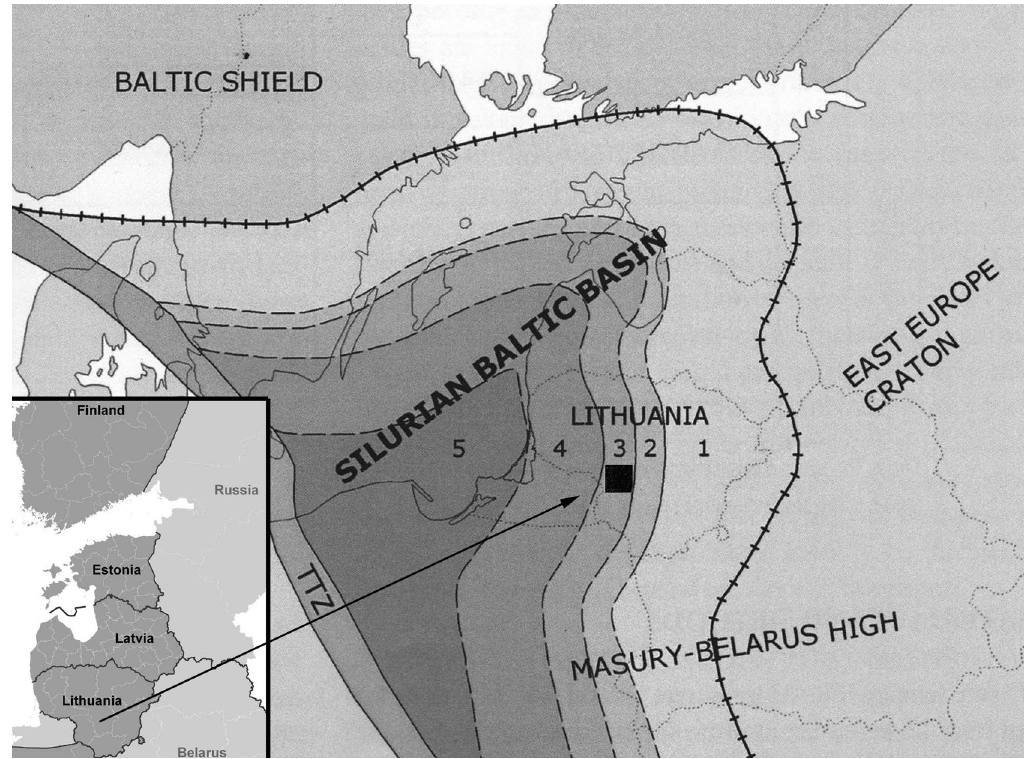
Fig. 2. The main facies belts of the Pridoli in the Baltic basin according to Bi č kauskas & Molenaar (2008b) and the studied area (black square). Facies belts: 1, intertidal-subtidal (sabkha); 2, inner-shallow ramp; 3, mid-ramp; 4, outer ramp; 5, lower ramp slope (cid:150) deep basin. TTZ, Teisseyre(cid:150)Tornquist